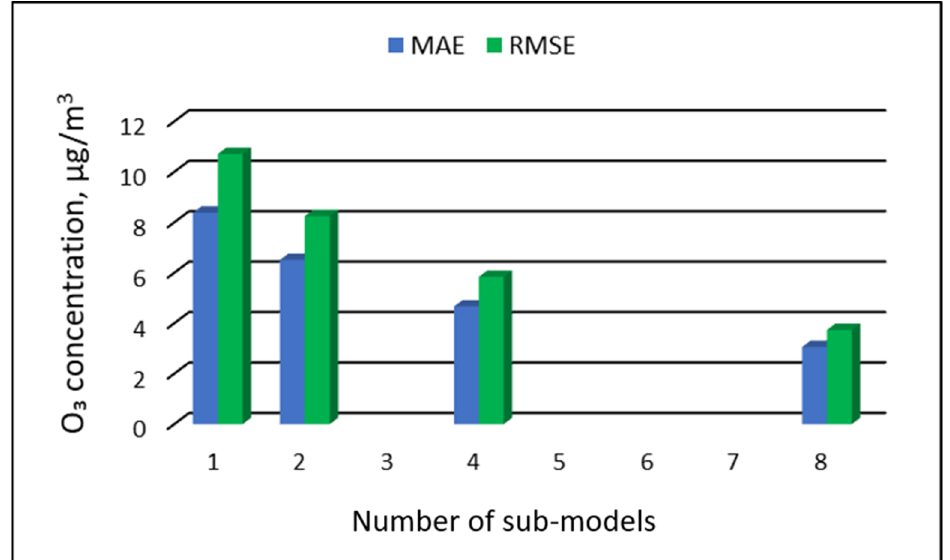
Figure 8. Overall MAE and RMSE values for O 3 concentration prediction in RVS models depending on the number of created sub-models, Z ł oty